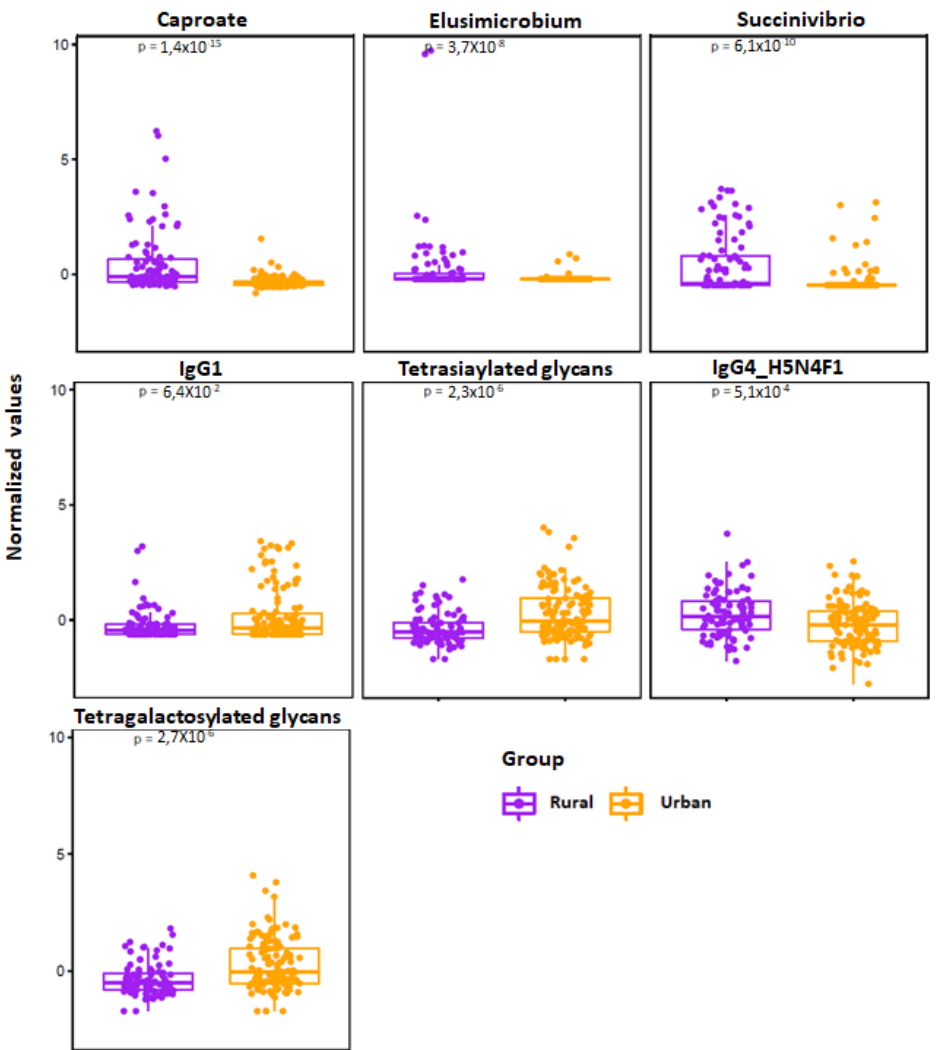
Figure 5. Jitter plot of the normalized selected features from elastic net analysis are shown for the rural ( n = 94) vs. urban ( n = 124) cohorts. Wilcoxon Rank test was performed and results were obtained, and p -values are shown in the respective plots.